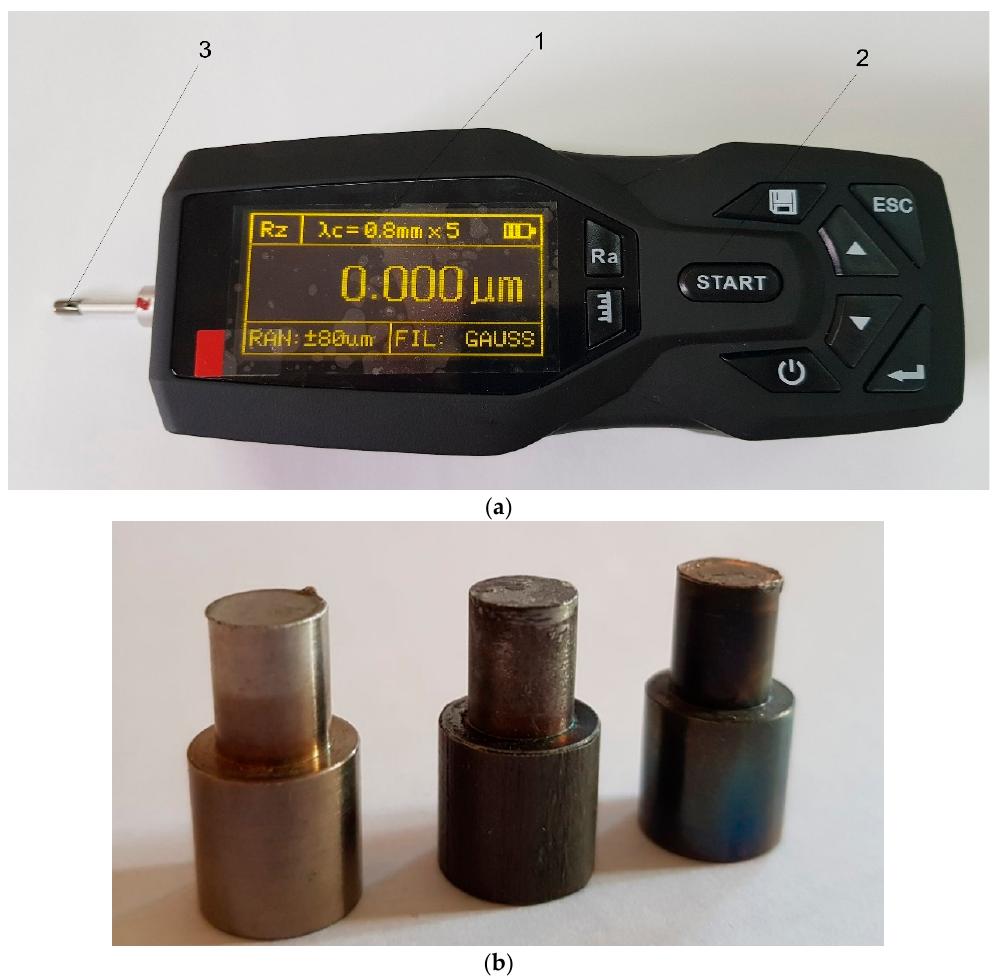
Figure 4. The view of a profilometer TR-200 ( a ) which is made up of: 1- display; 2- control panel; 3- sensor (pickup) and treated samples ( b ).